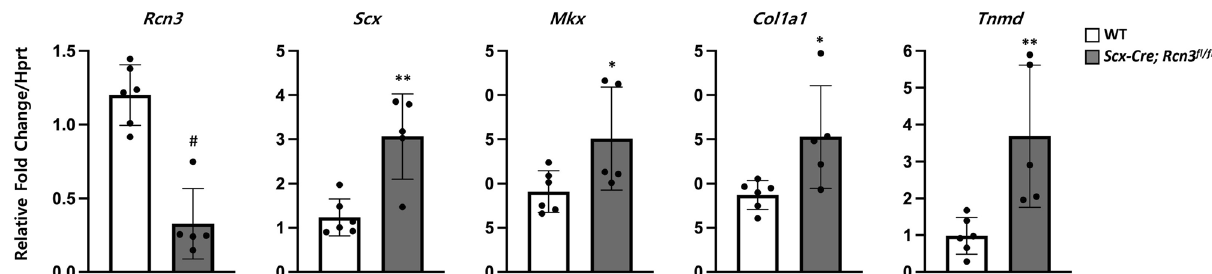
Figure 5. Quantitative real-time PCR of Achilles tendons from wild-type mice and Scx-Cre; Rcn3 fl/fl (tendon- specific Rcn3 loss-of-function model) littermates at P28 (C). (* indicates P < 0.05, ** indicates P < 0.01 and # indicates P < 0.001 between genotypes, wild-type mice n = 6, Scx-Cre; Rcn3 fl/fl mice n =